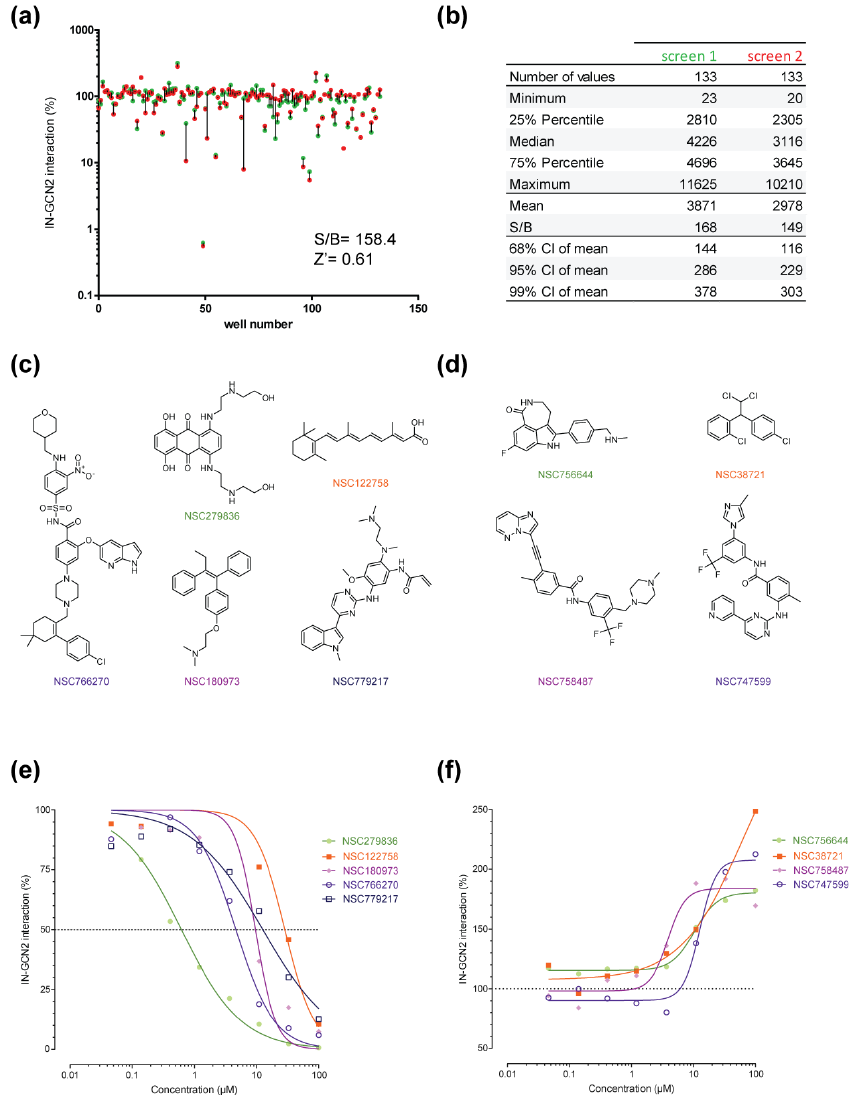
Figure 3. Screening of the DTP oncology set. ( a ) Effect of FDA-approved anticancer drugs on the IN – GCN2 interaction monitored using AlphaLISA. Each compound was tested at a single dose of 100 µM. The plate design was changed to reproduce the experiment and the two independent replicates are represented as red and green dots, linked by a straight vertical line. ( b ) Assay diagnostics. ( c , d ) Chemical structure of the best five inhibitors ( c ) and four stimulators ( d ) of the IN – GCN2 interaction. ( e , f ) Dose-response curves obtained with either the inhibiting ( e ) or the stimulating compounds ( f ).